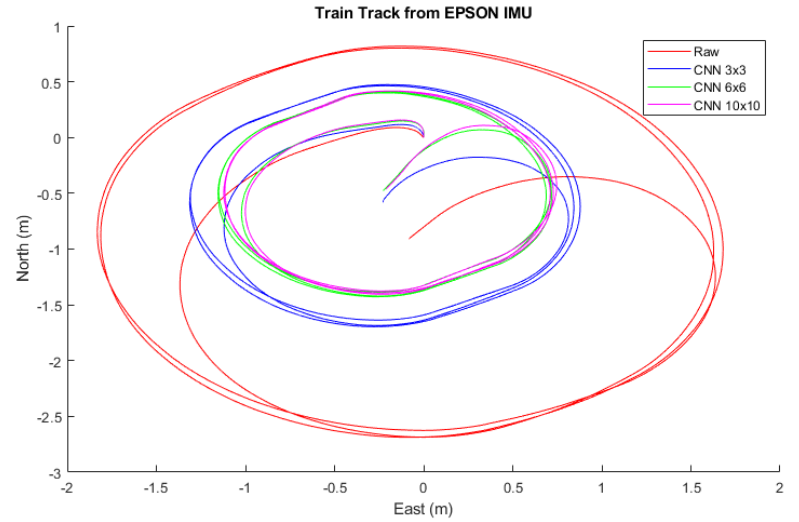
Figure 7. Two − Dimensional Train tracks drawn from EPSON IMU raw data, 10 × 10 × 1, 6 × 6 × 1, and 3 × 3 × 1 CNN.